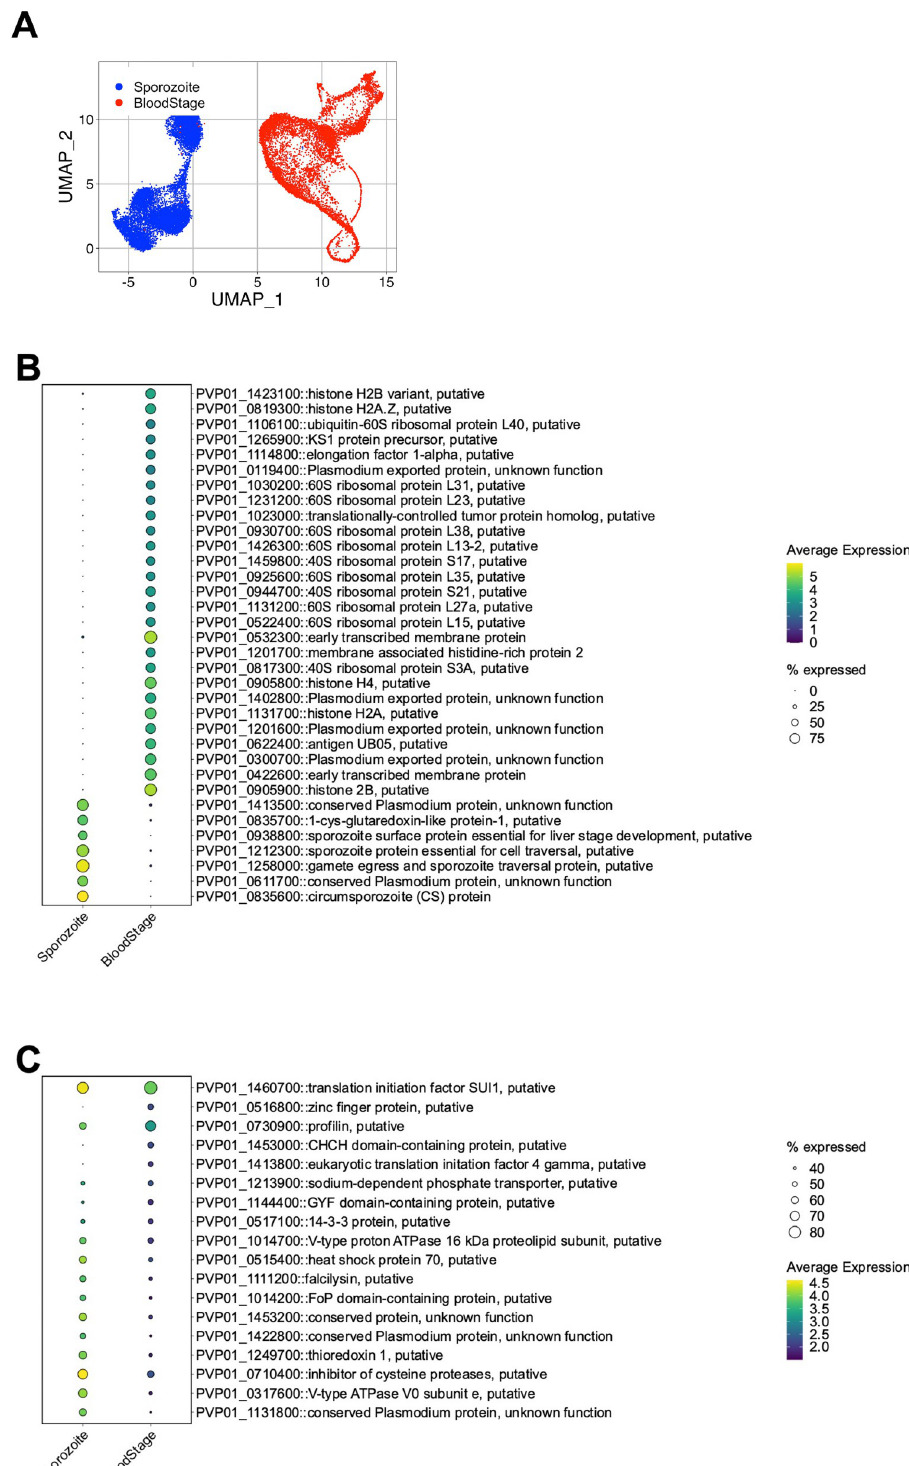
Fig 6. Integration and comparative analyses of P . vivax sporozoite and blood-stage parasite transcriptomes. (A) UMAP of integrated P . vivax sporozoite and blood-stage parasite transcriptomic data. (B) Dot plot highlighting the top differentially expressed genes with stage-specific specific expression patterns (absolute difference in gene detection > 65% between sporozoites and blood stages). (C) Dot plot highlighting the top differentially expressed